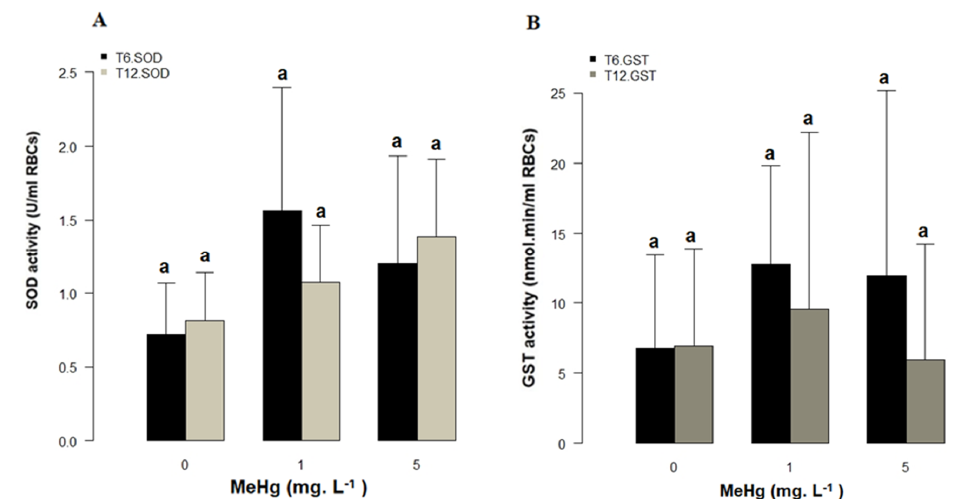
Figure 4. Activities of (A) Superoxide dismutase (SOD) and (B) glutathione S-transferase (GST) in erythrocytes of loggerhead turtles exposed to methylmercury (MeHg) at 0, 1 and 5 mg L −1 for 6 and 12 h (mean ± standard error of the mean, (n = 5). Differences between treatments were statistically non-significant in all cases ( p > 0.05).